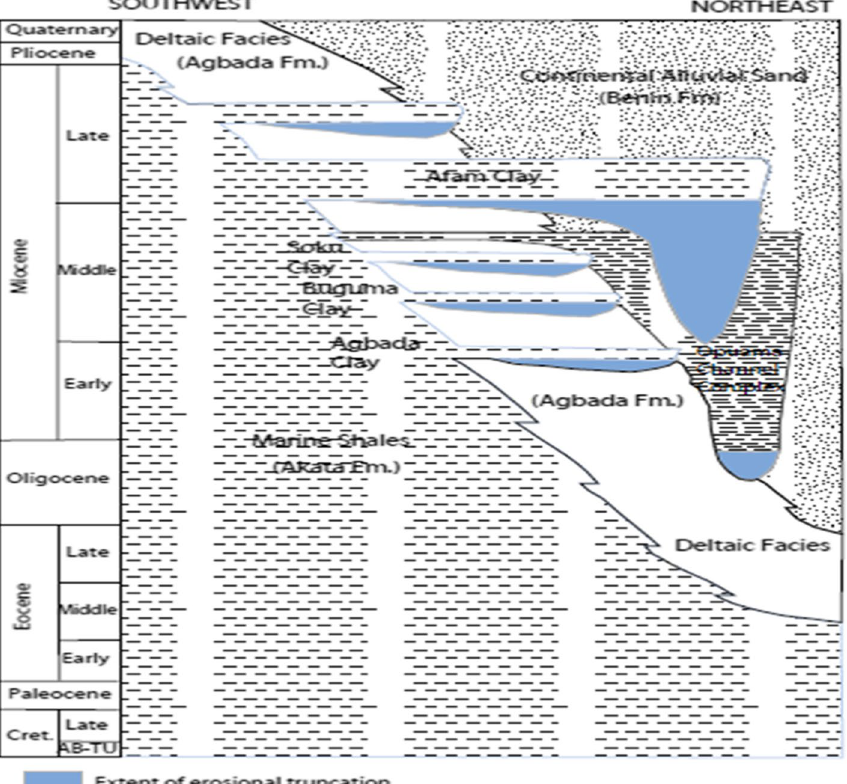
Fig. 4 Stratigraphic column shows the three formations of the Niger Delta